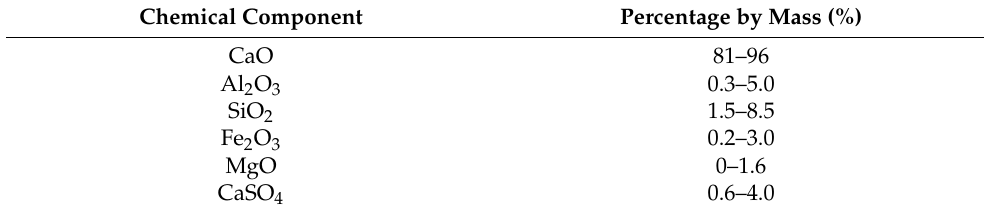
Table 2. Chemical composition of SCDA. Chemical